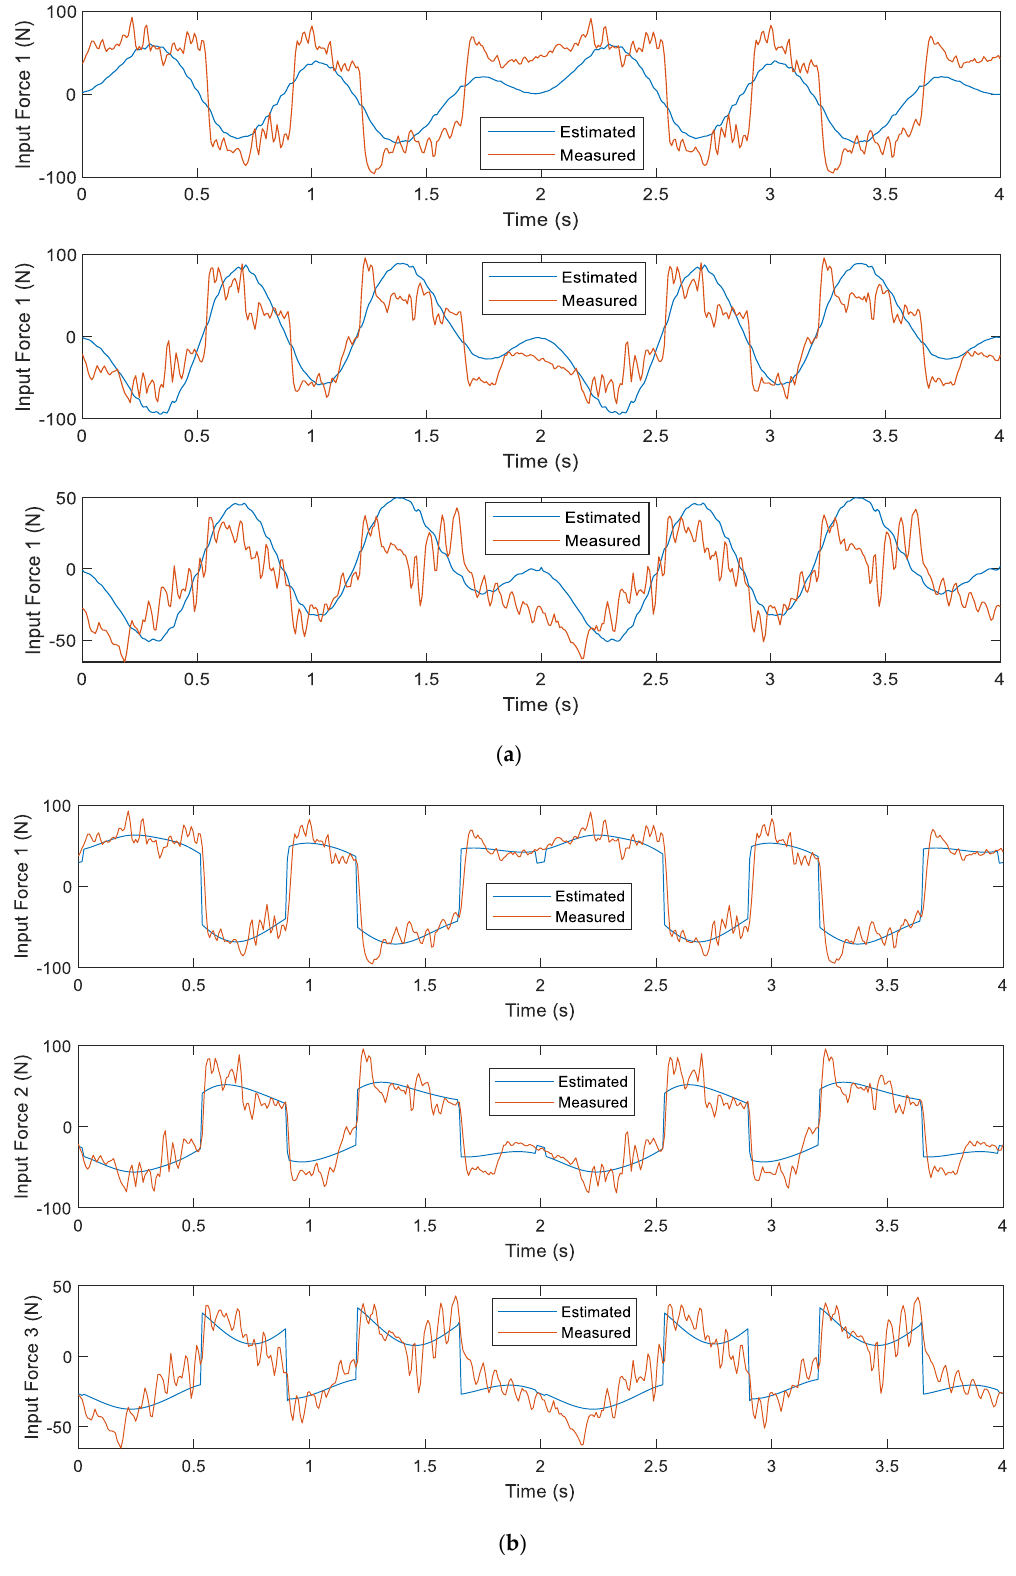
Figure 12. Comparison between the estimated and measured input forces: ( a ) using the Coulomb-viscous friction model and ( b ) using the Stribeck friction model.